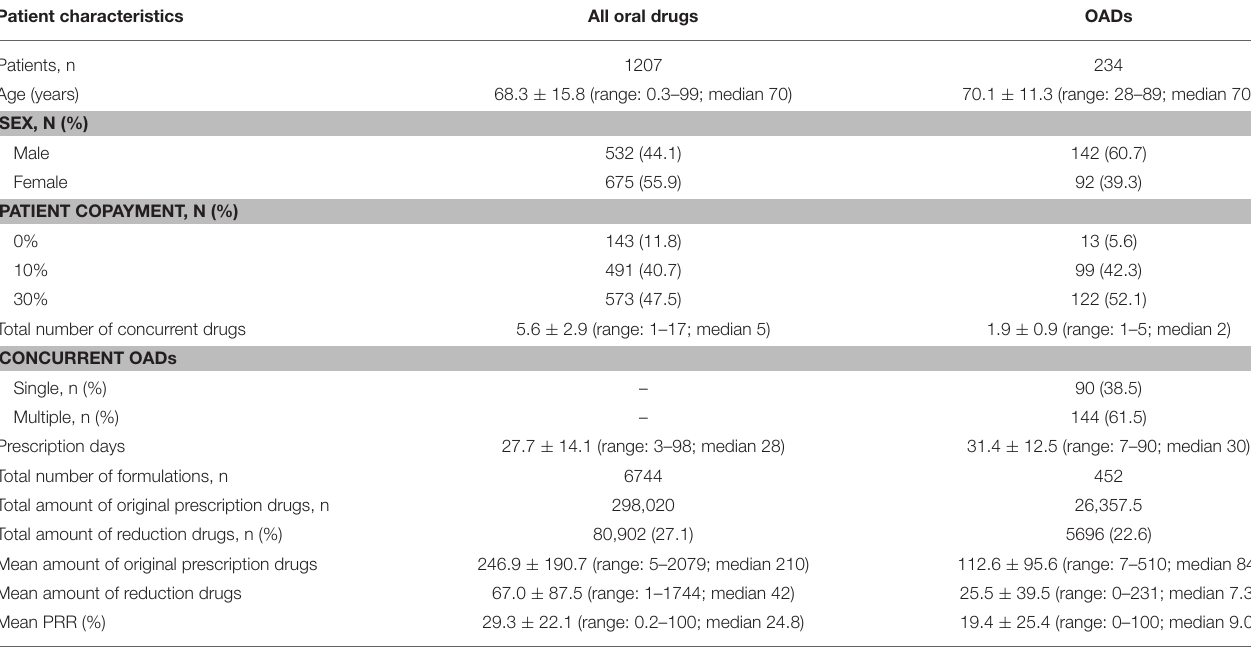
TABLE 1 | Characteristics of the patients and their